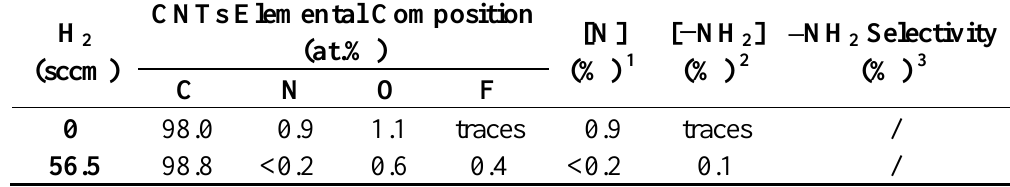
Table 3. XPS analysis of CNTs in function of H discharge chamber: relative content in [N] and [NH2] and primary amine